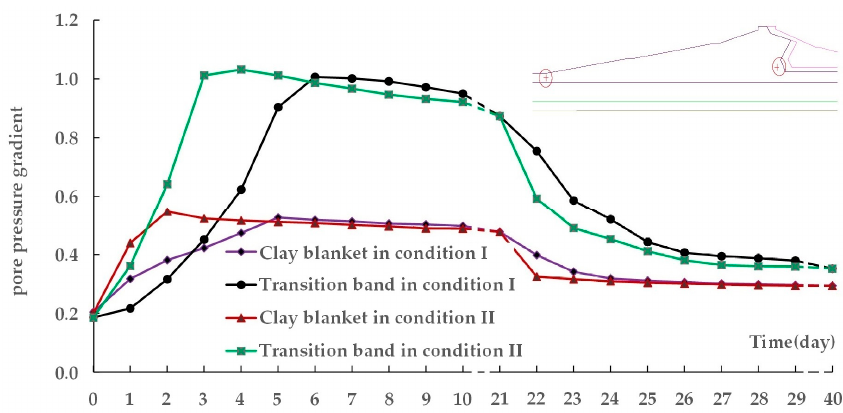
Figure 15. Curves of maximum pore pressure gradients at two locations (upstream blanket and transition band as shown by the inset at top right) under Condition I and Condition II.